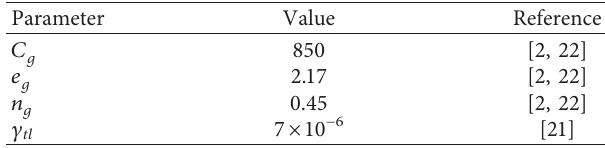
Table 1: Calibrated parameters of the proposed yield surface for Toyoura sand.